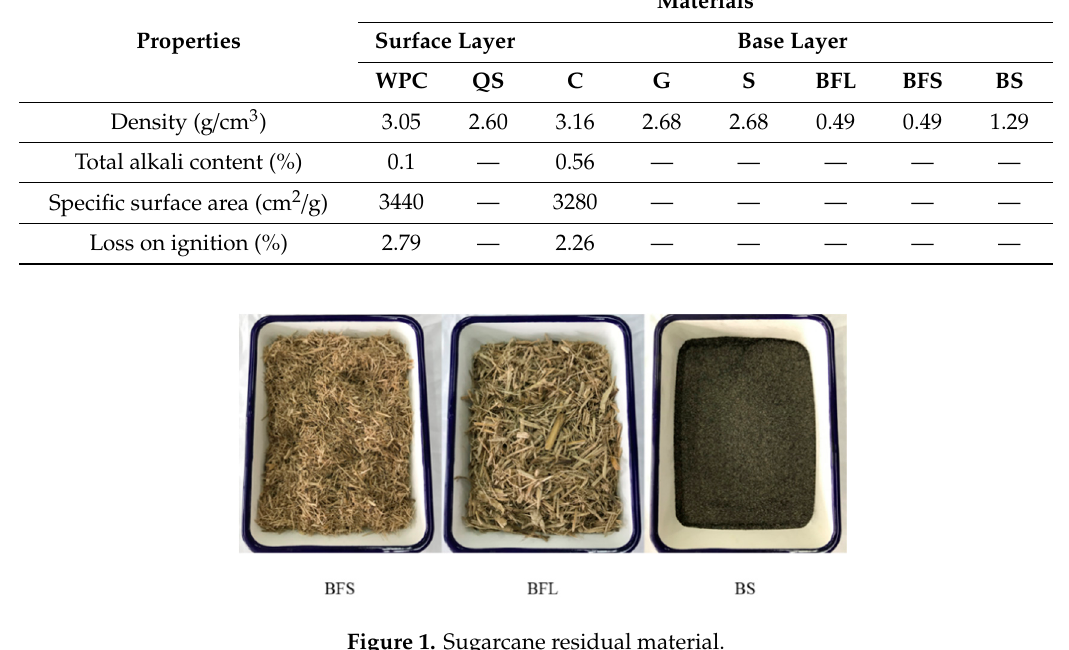
Figure 1. Sugarcane residual material.